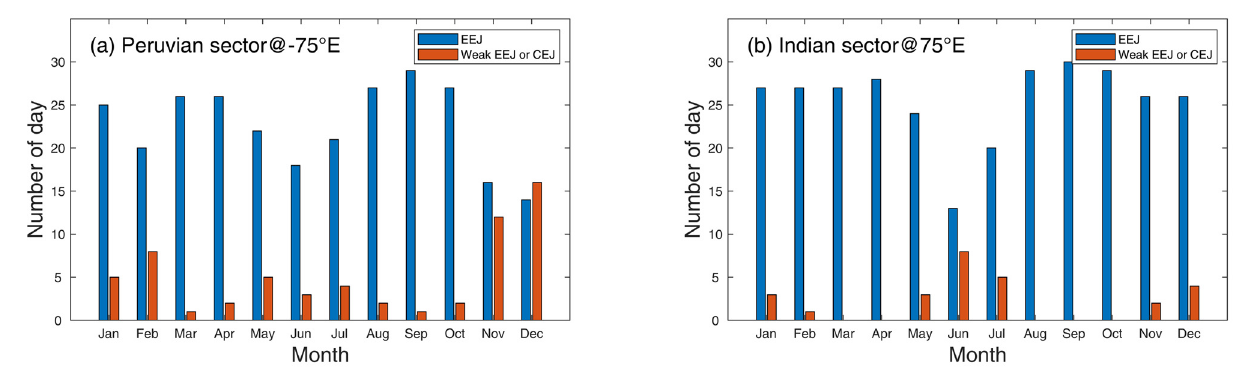
Figure 2. Number of days with EEJ signatures and weak EEJ or CEJ signatures at ( a ) Peruvian sector and ( b ) Indian sector. and ( b ) Indian